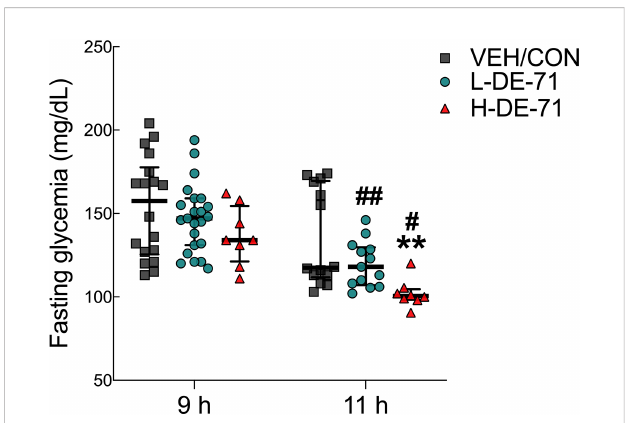
FIGURE 2 Fasting blood glucose (FBG) in male offspring exposed perinatally to DE-71. FBG was measured after a 9h fast in conjunction with ITT and 11h fast before GTT in male offspring. *indicates signi fi cantly different from VEH/CON (** p <0.01). # indicates signi fi cant difference vs 9 h fast for corresponding exposure group ( # p< 0.05; ## p <0.01). Bars and error bars represent values expressed as median with interquartile range. n ,